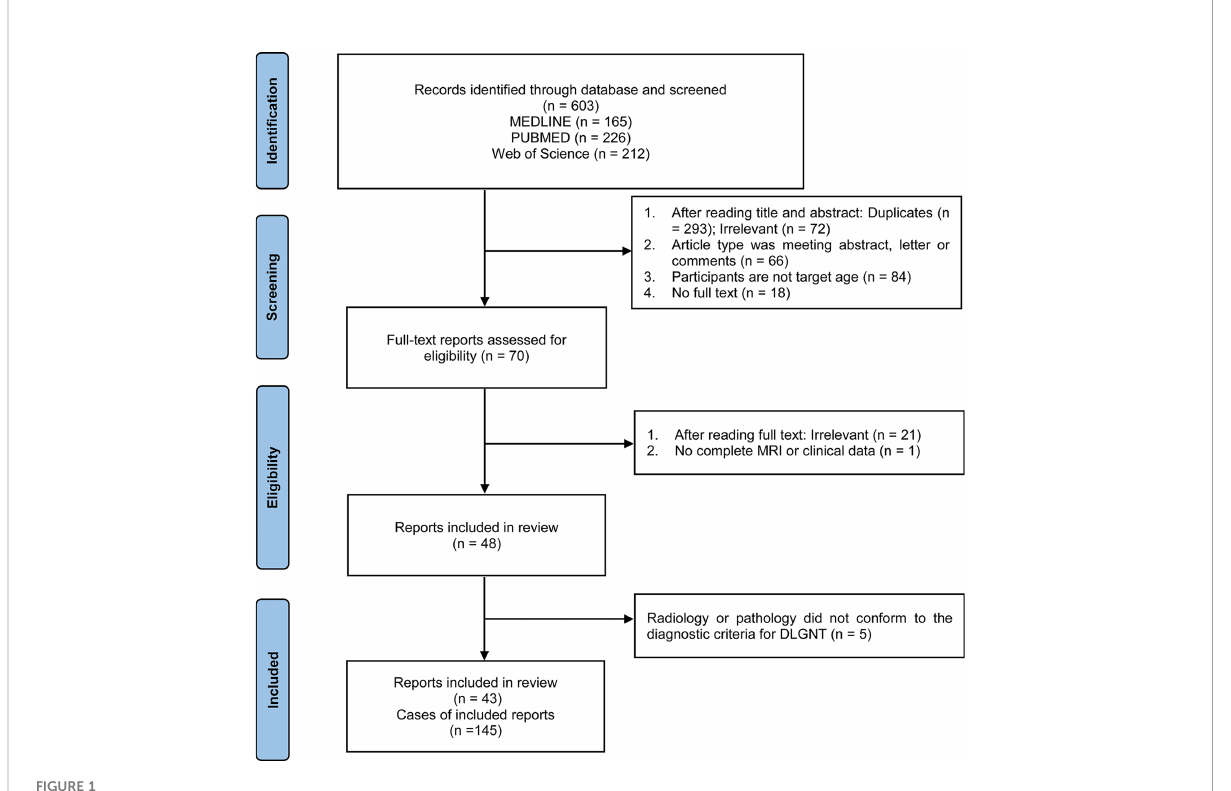
FIGURE 1 Flow chart showing the selection of